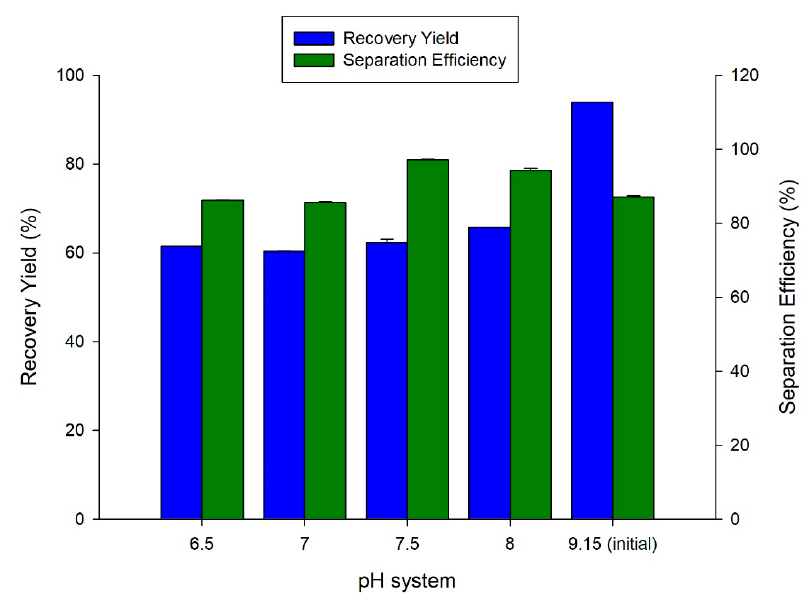
Figure 7. Figure showing the effect of pH system on protein recovery yield and separation efficiency.